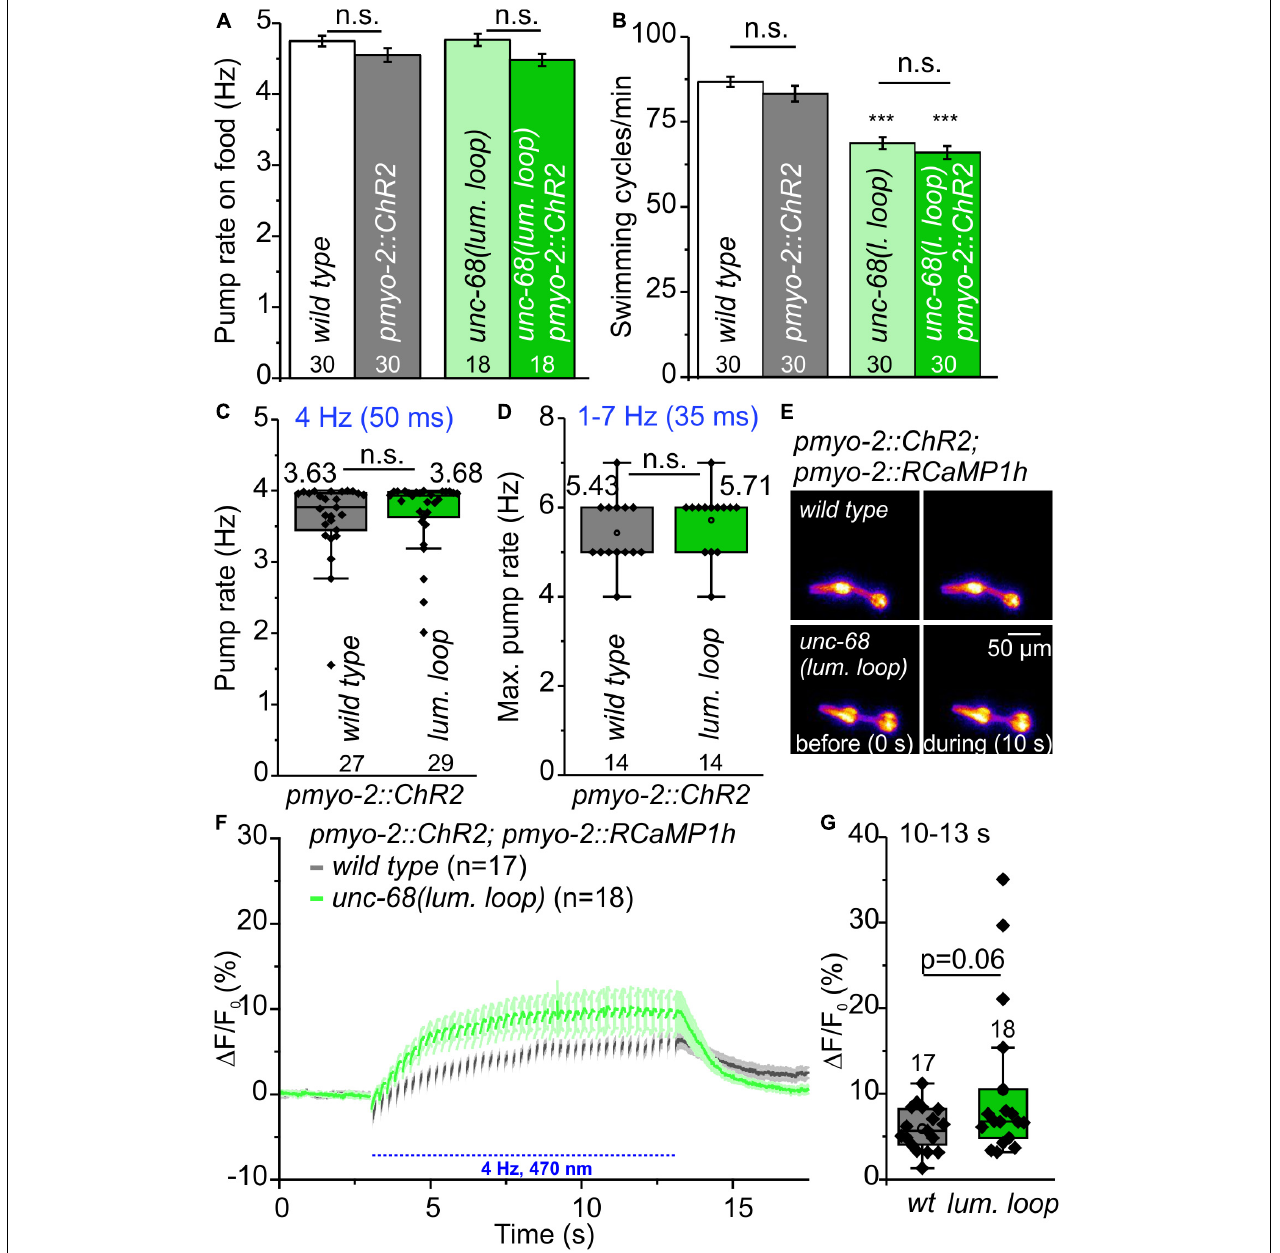
FIGURE 7 | Characterization of neutral amino acid insertion into UNC-68 luminal loop (lum. loop). (A,B) No effect on spontaneous pumping on food and reduced number of swimming cycles/min evoked by neutral luminal loop insertion. (C) Pumping ability is not reduced in the ScreenChip TM system (4 Hz stimulation, 60 s). (D) No effect on maximal pump rate of cut-head preparations in the stress test. (E) Exemplary false-color representation of fluorescence intensity. (F) Mean ± SEM of the (cid:49) F/F 0 of RCaMP1h fluorescence before and during light stimulation. (G) The amplitudes of (cid:49) F/F 0 (mean: 10–13 s) show no significant difference between wild-type and neutral luminal loop-expressing animals. Bar graphs represent mean ± SEM, box plots include data points (rhomb), mean (circle), and median (line). N-numbers and significance levels (asterisks) are displayed. One-way ANOVA with the Bonferroni test (A,B) or a two-sample t -test (C,D,G) : n.s., not significant, and *** P ≤